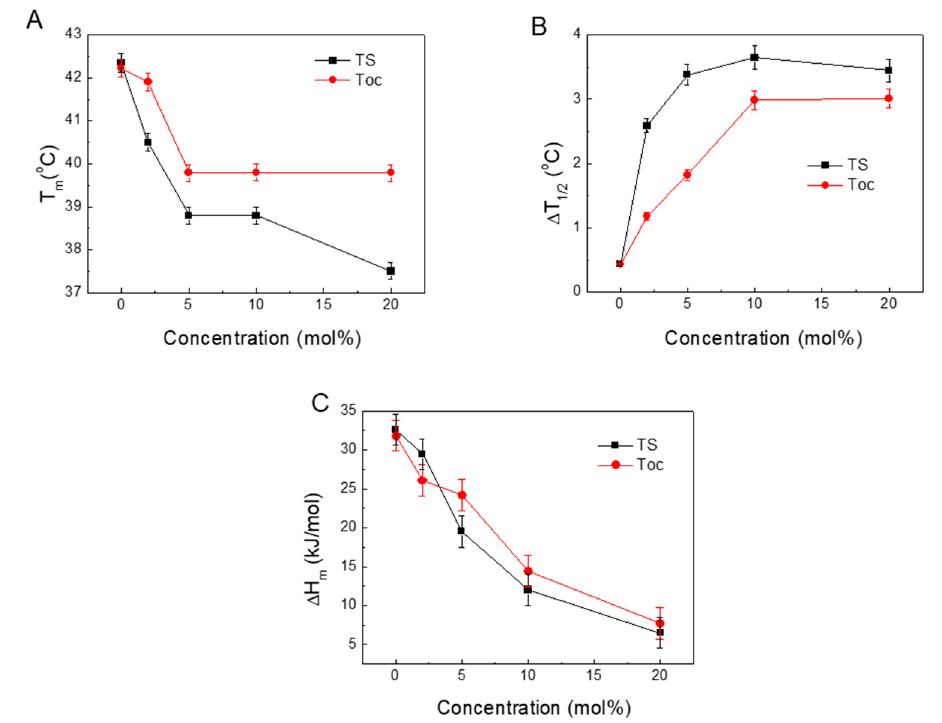
Figure 7. Plots of the parameters calculated from the DSC thermograms: temperatures of the main transition (T m ) ( A ), half-width of the peak ( Δ T 1/2 ) ( B ), enthalpy of the main transition ( Δ H m ) ( C ).